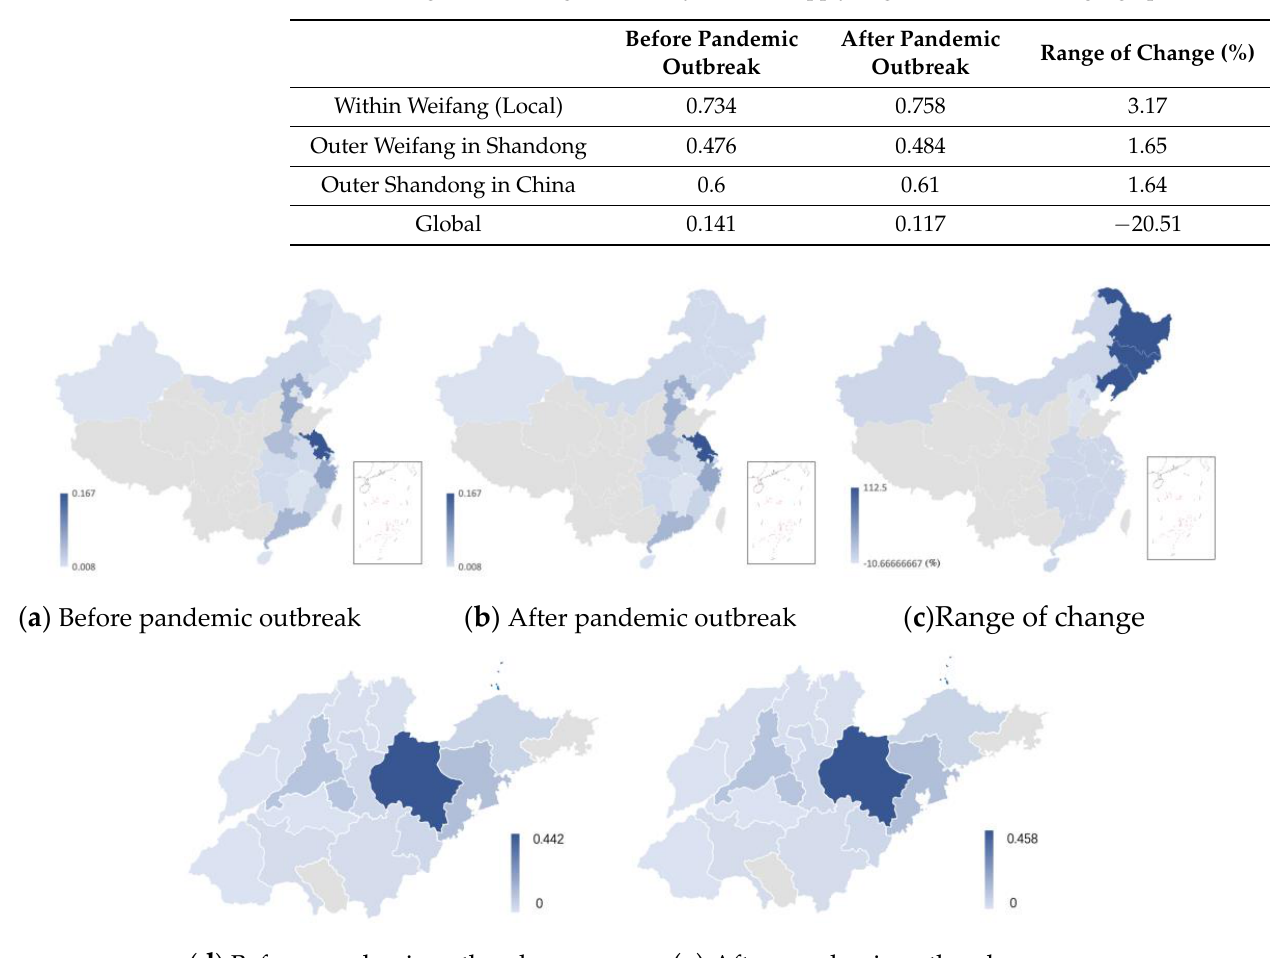
Table 3. Changes in node degree centrality of firms’ supply originations at different geographical scales.